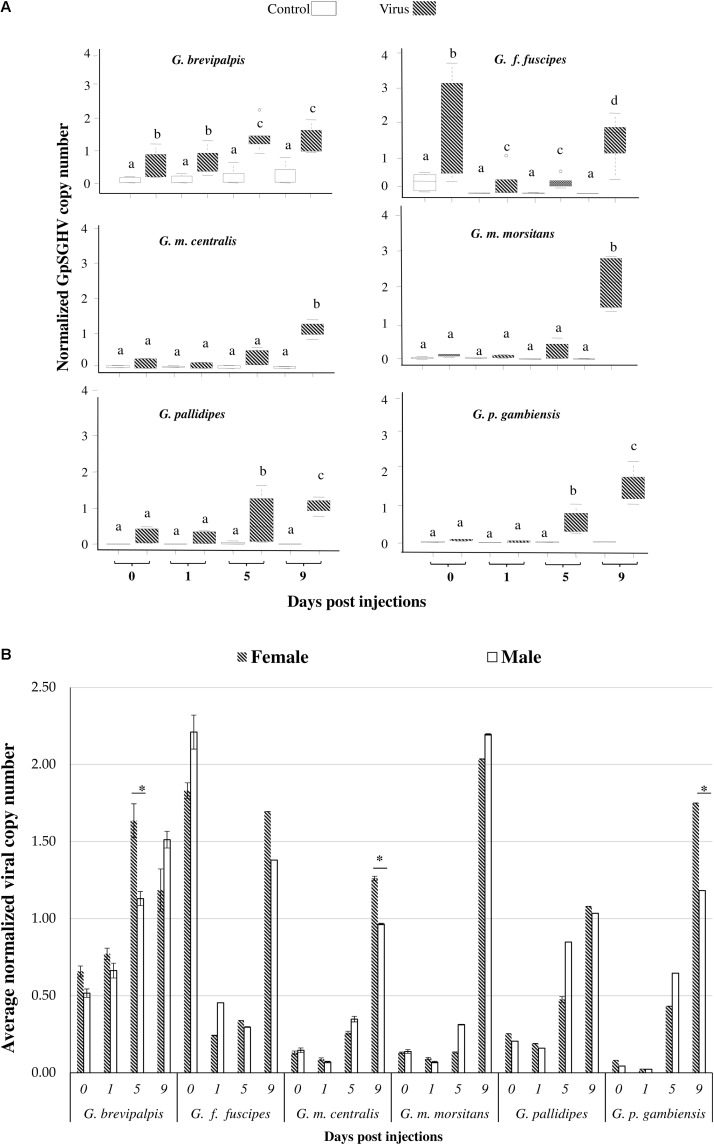
Susceptibility of Glossina species to GpSGHV infection. (A) GpSGHV copy number of six tsetse species. (B) Difference in GpSGHV copy number between males and females. Teneral adults from the six Glossina species were injected (intra-hemocoelic) with GpSGHV suspension and PBS, Viral copy numbers were quantified by qPCR from flies sampled from each species at 0, 1, 5, and 9 days post adult emergence. The qPCR data were normalized against the tsetse housekeeping gene, β-tubulin. Different letters in A and star(∗) in B indicate significant difference at the p = 0.05 level (Tukey HSD at the 95% family wise confidence level).